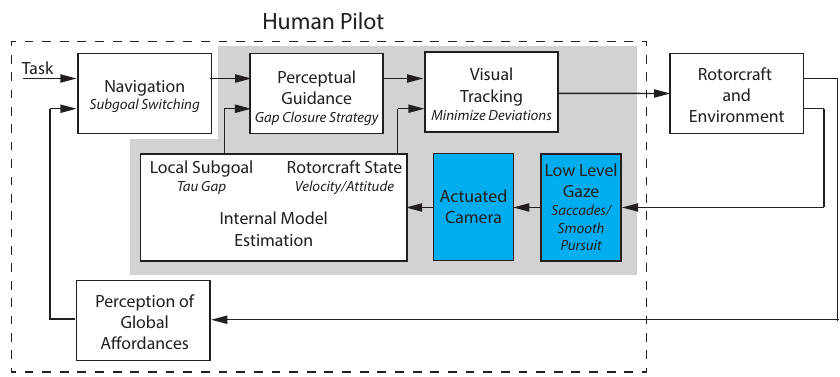
Figure 20. The components implemented for each example application are highlighted. The blue boxes are the components for the actuated camera and the blocks inside the gray boundary are implemented in the augmented control